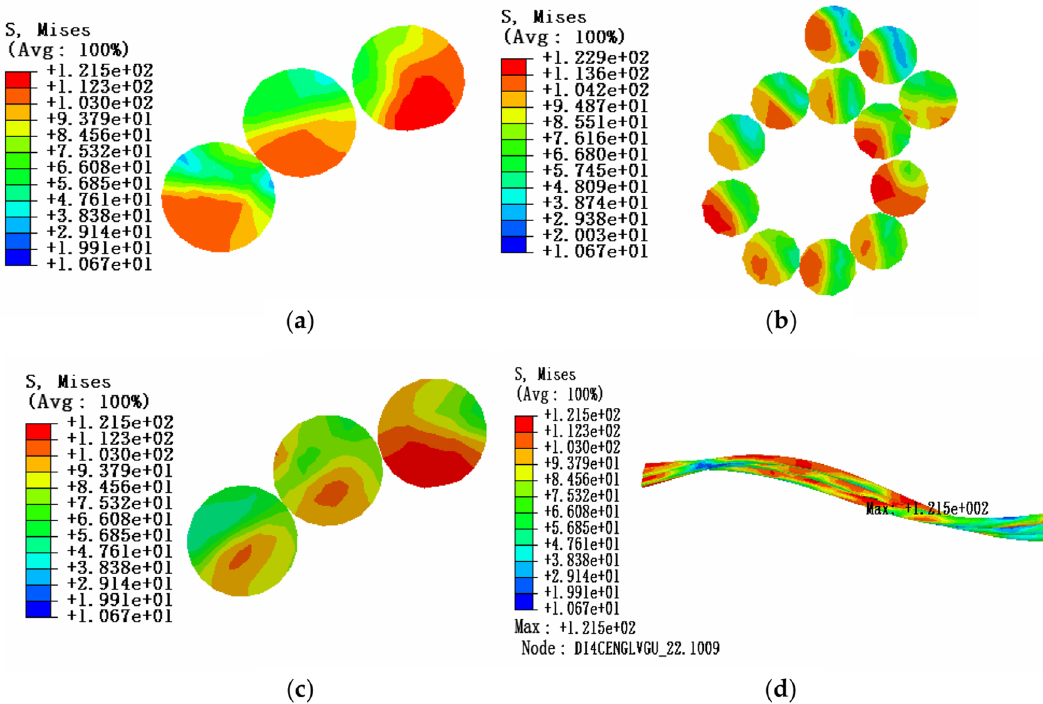
Figure 13. Equivalent stress cloud diagram of aluminum strand without friction ( a) Equivalent stress cloud diagram at maximum stress; ( b ) Equivalent stress cloud diagram at the middle point section; ( c ) Equivalent stress cloud diagram at 0.5 times the pitch diameter; ( d ) Overall equivalent stress cloud diagram of aluminum strand.